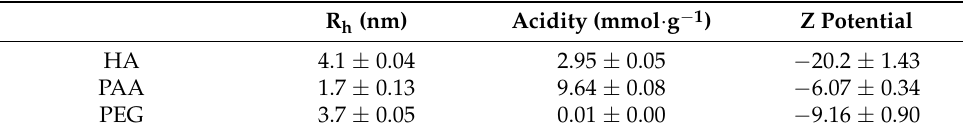
Table 1. Hydrodynamic radius, acidity, and charge (Z potential) of the different macromolecules in solution at work concentration and pH. The values correspond to the mean value ( n = 3) ± standard